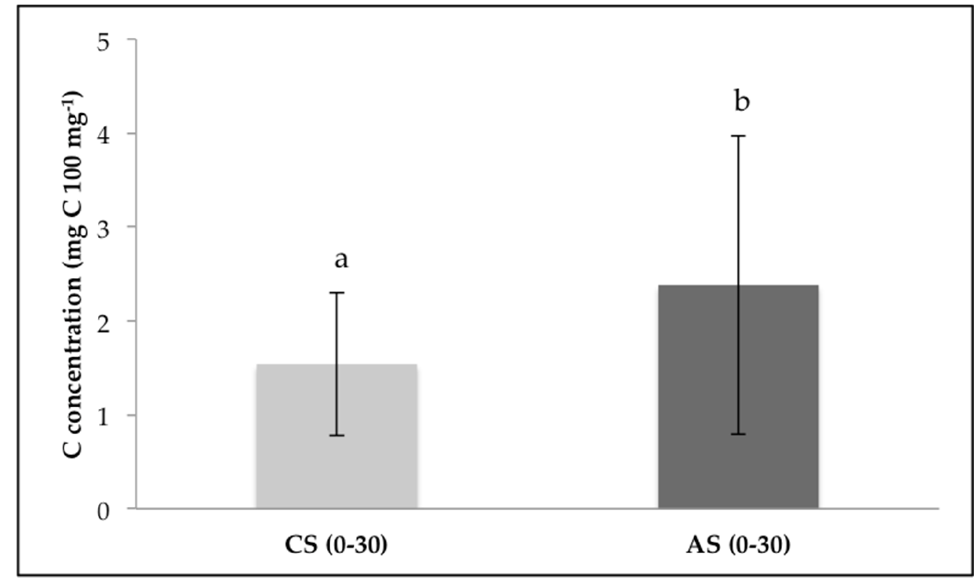
Figure 3. Comparison between the values of C concentration (mg C 100 mg − 1 ) in the first 30 cm of cultivated soils (CS) and abandoned soils (AS); a, b: different letters indicate significant differences (Student’s t -test of paired samples, p < 0.05).